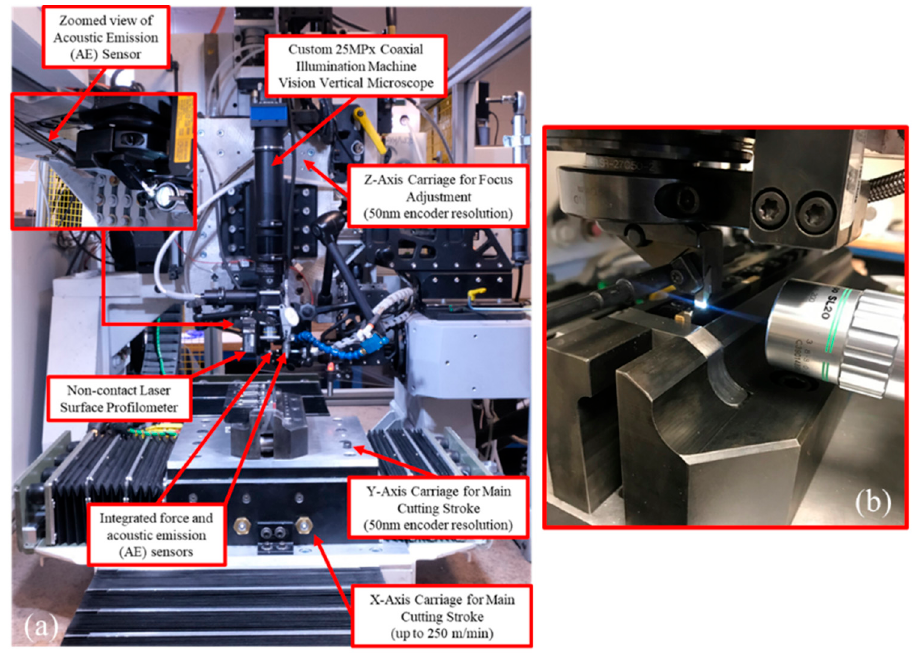
Figure 4. ( a ) Custom in situ testbed developed at the authors’ laboratory, and ( b ) a zoomed-in view of the cutting zone. of the cutting